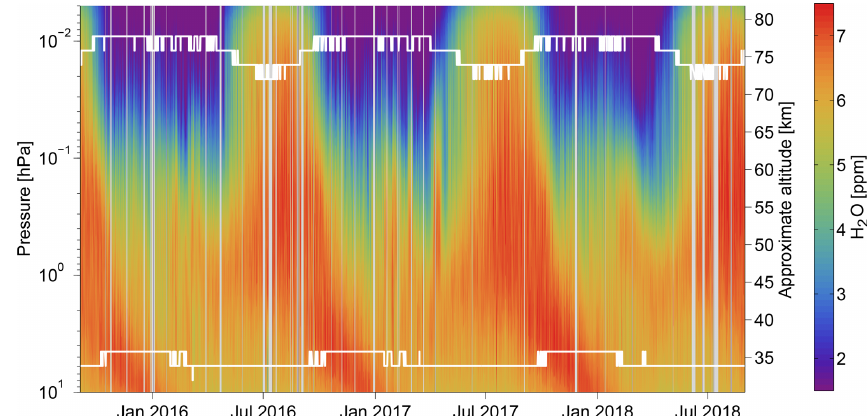
Figure 1. Time series of MIAWARA-C water vapour profiles from Ny-Ålesund. The horizontal white lines indicate the measurement response of 0.8.